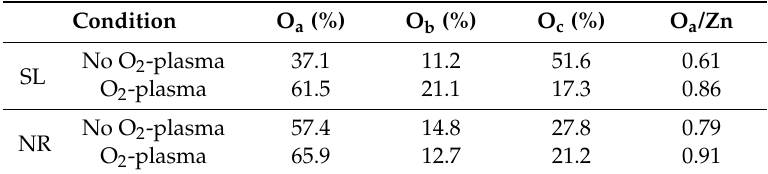
Table 2. Percentage values of the XPS O-1s satellite peaks from as-coated and O 2 -plasma-treated (for 9 min) SLs and NRs grown on each SL crystal. Each percentage value was calculated by dividing the curve integration of individual satellite peak by the curve integration of total